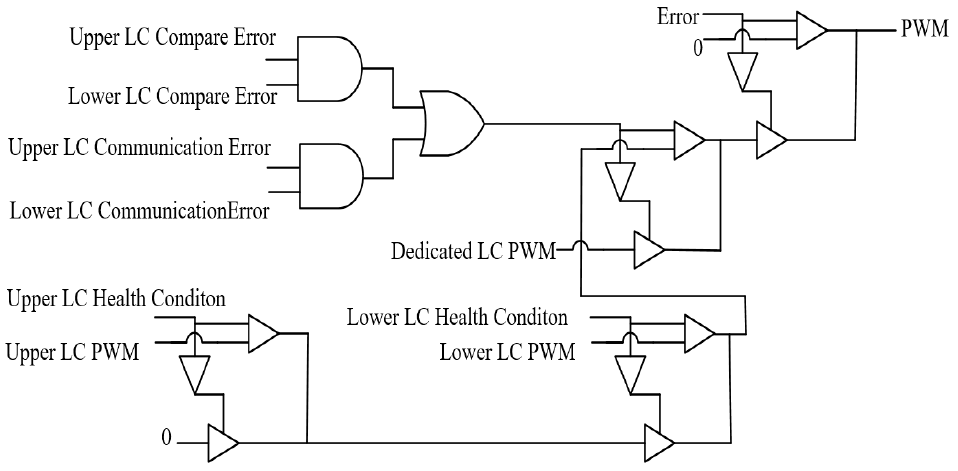
Figure 6. A logic diagram of the SM controller failure detection.